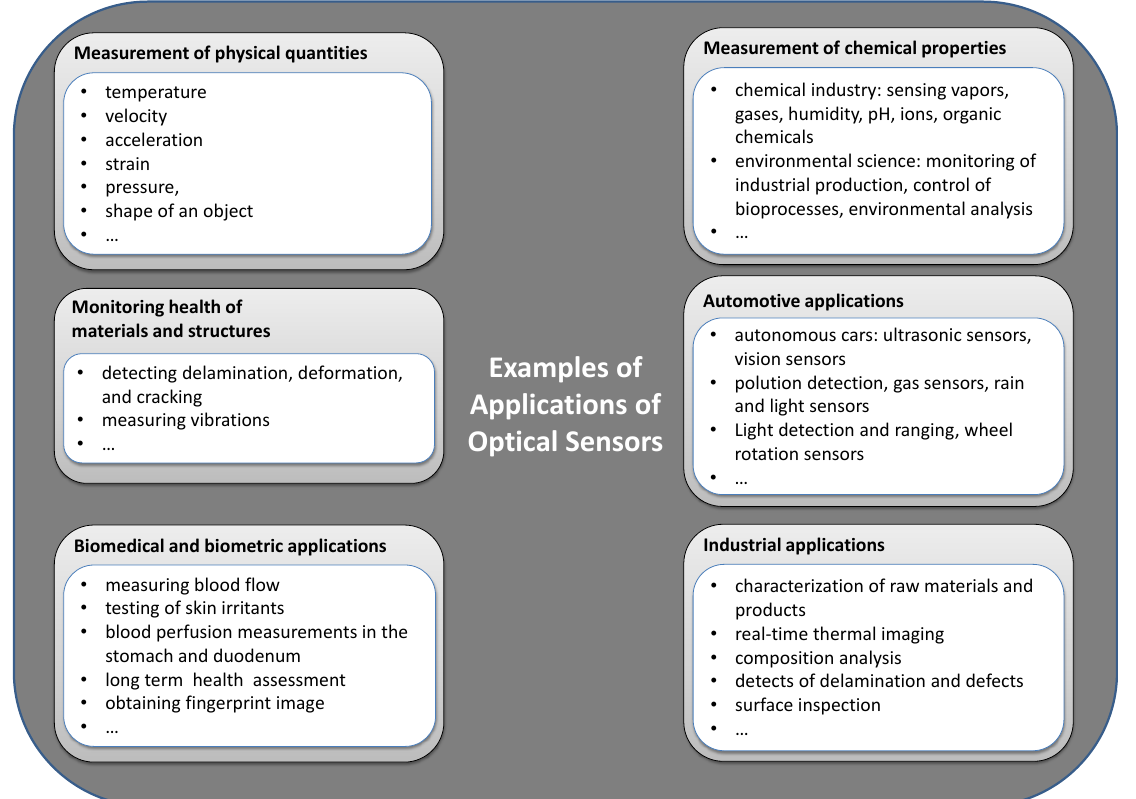
Figure 2. Some examples of possible applications of optical sensors.